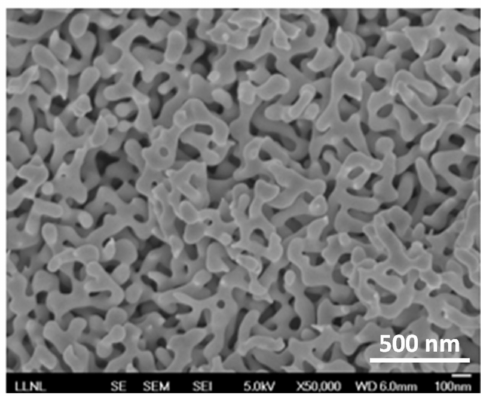
Figure 1. Scanning Electron Microscope (SEM) image of the Au